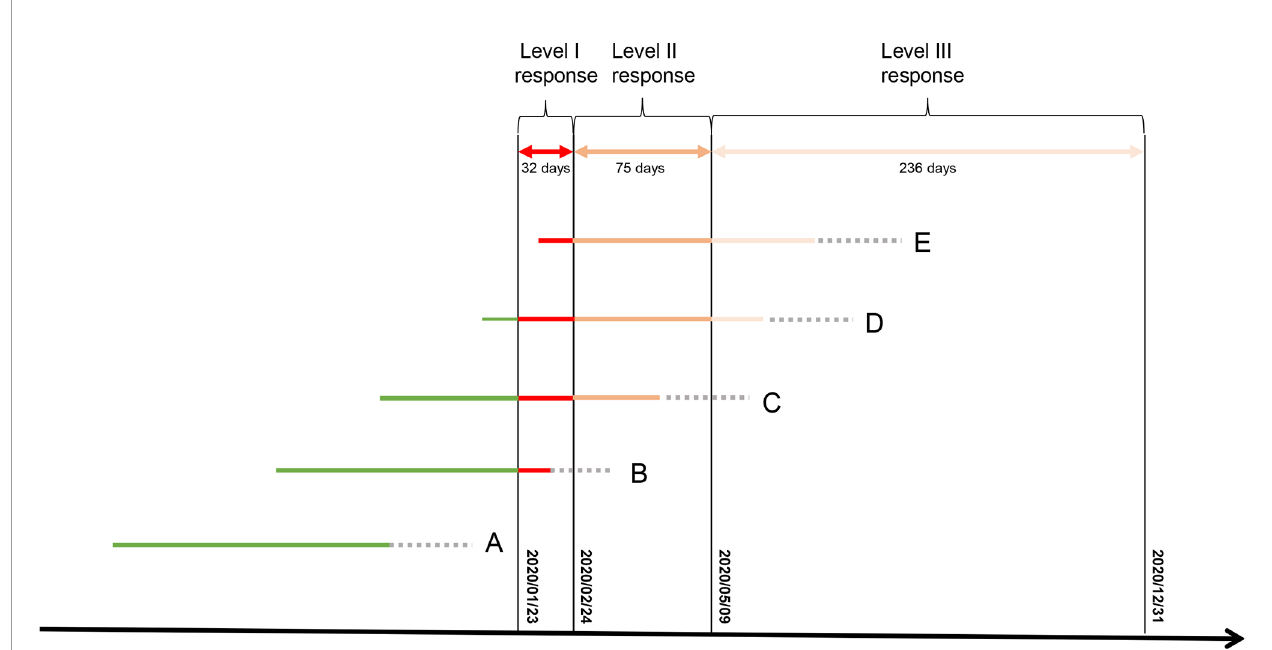
FIGURE 2 | Approach to calculating individual cumulative exposure dose to lockdown in the fi rst 28 GWs. Weeks after 28 GWs. (A – E) represent subgroups of pregnant women with different GWs during the Level I lockdown; We assigned a weighting value of 3 to the days with Level I response, 2 to the days with Level II response, 1 to the days with Level III response, and 0 to days before lockdown (no